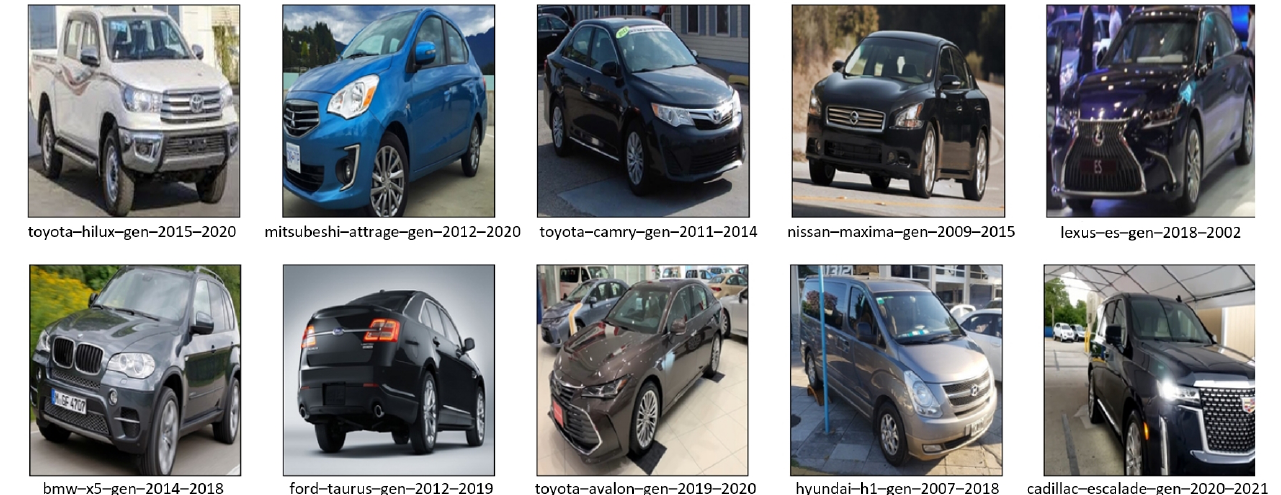
Figure 1. Sample images of the dataset used for car model classification (input size of 224 × 224). The labels below each image show the car’s make, model, and generation.